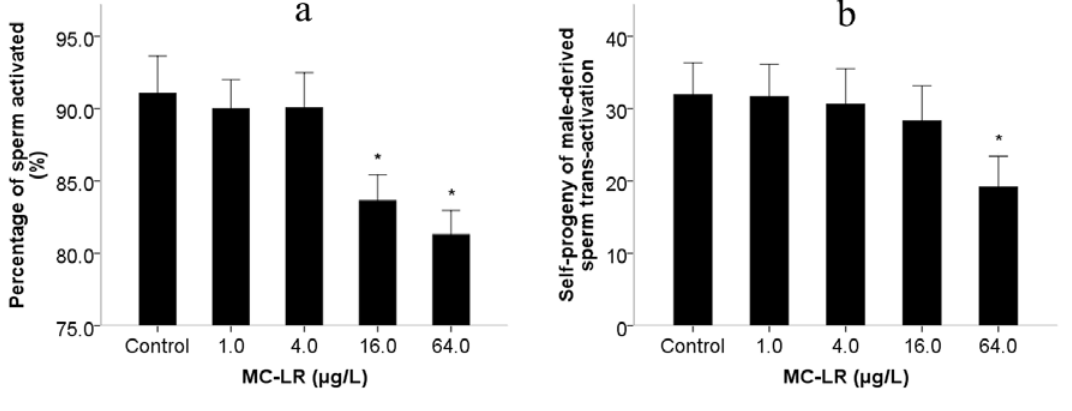
Figure 1. Effects of microcystin-leucine arginine (MC-LR) exposure on nematodes sperm activation ( a ) him-5 sperm activation in vitro with Pronase; and ( b ) Number of self-progeny of male-derived sperm trans-activation. Bars represent means ± SEM. * p < 0.05 vs . the control